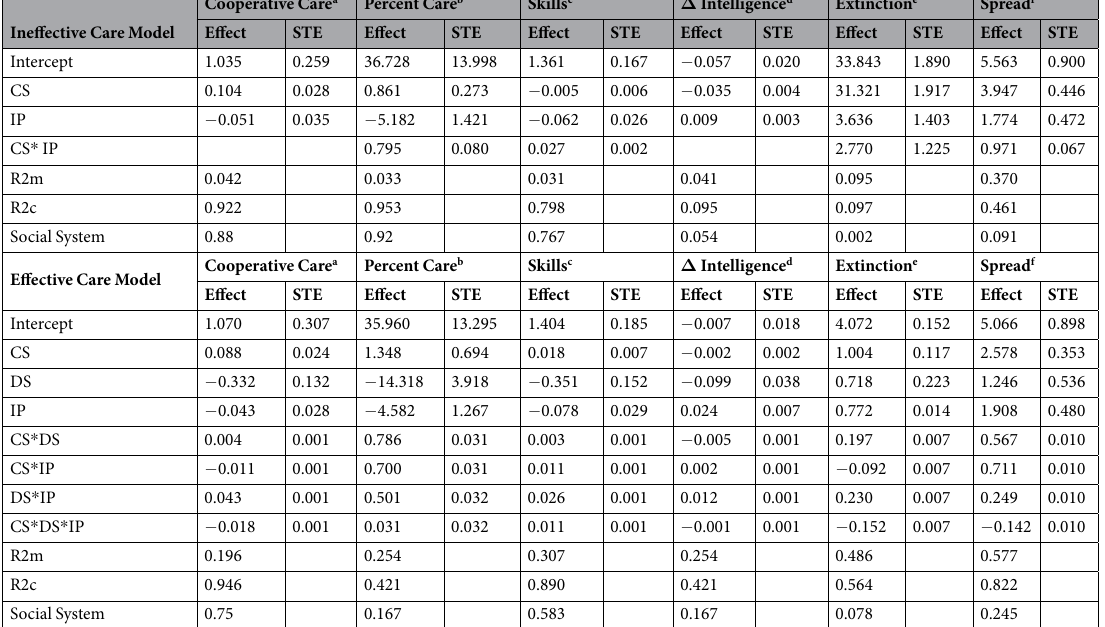
Table 2. Estimated effect sizes (Effect) and standard errors (STE) for the Ineffective Care and Effective Care models. a Cooperative care is the mean number of care events received by diseased individuals. b Percent Care is the percentage of diseased individuals who received care from at least one carer. c Skills is the mean number of care-giving skills per agent in the population. It represents the social learning of care-giving skills because agents with more than one skill have acquired the addition skills through social learning. d Δ Intelligence is the change in population intelligence. e Extinction is the time to disease extinction. f Spread is the percentage of infected who were infected by another agent. Both the Ineffective Care and the Effective Care models account for changes in community size (CS) and the initial prevalence of the diseases (IP), while the Effective Care model also accounts for disease severity (DS). R2m (marginal) 77 is the percentage of the variation explained by the fixed effects (Ineffective Care Model: Community Size, Initial Prevalence, Community Size * Initial Prevalence; Effective Care Model: Community Size, Initial Prevalence, Disease Severity, and interaction effects), whereas R2c (conditional) is the percentage of the variation explained by taking into account both the fixed and random portions (Social System) of the model. Social system is the percent of the variation explained by the effect of social system and is calculated as the difference between R2m and